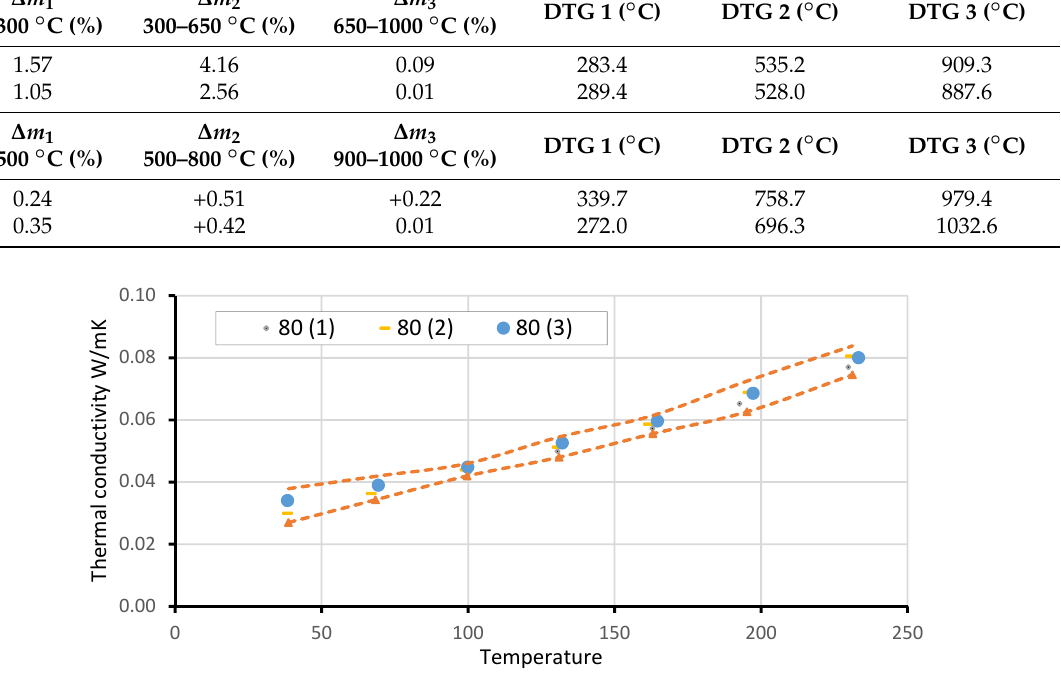
Figure 6. Dependence of the thermal conductivity coefficient (W/m°C) from the temperature (°C) for three samples with a density of 80 kg/m 3 .